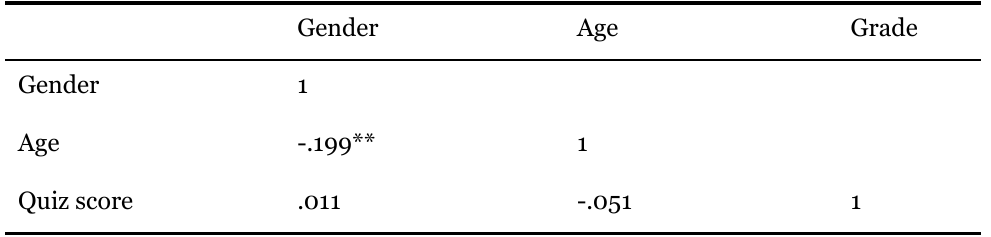
Correlations Between Gender, Age, and Grade Gender Age Grade Gender 1 Age -.199** 1 Quiz score .011 -.051 1 ** p =